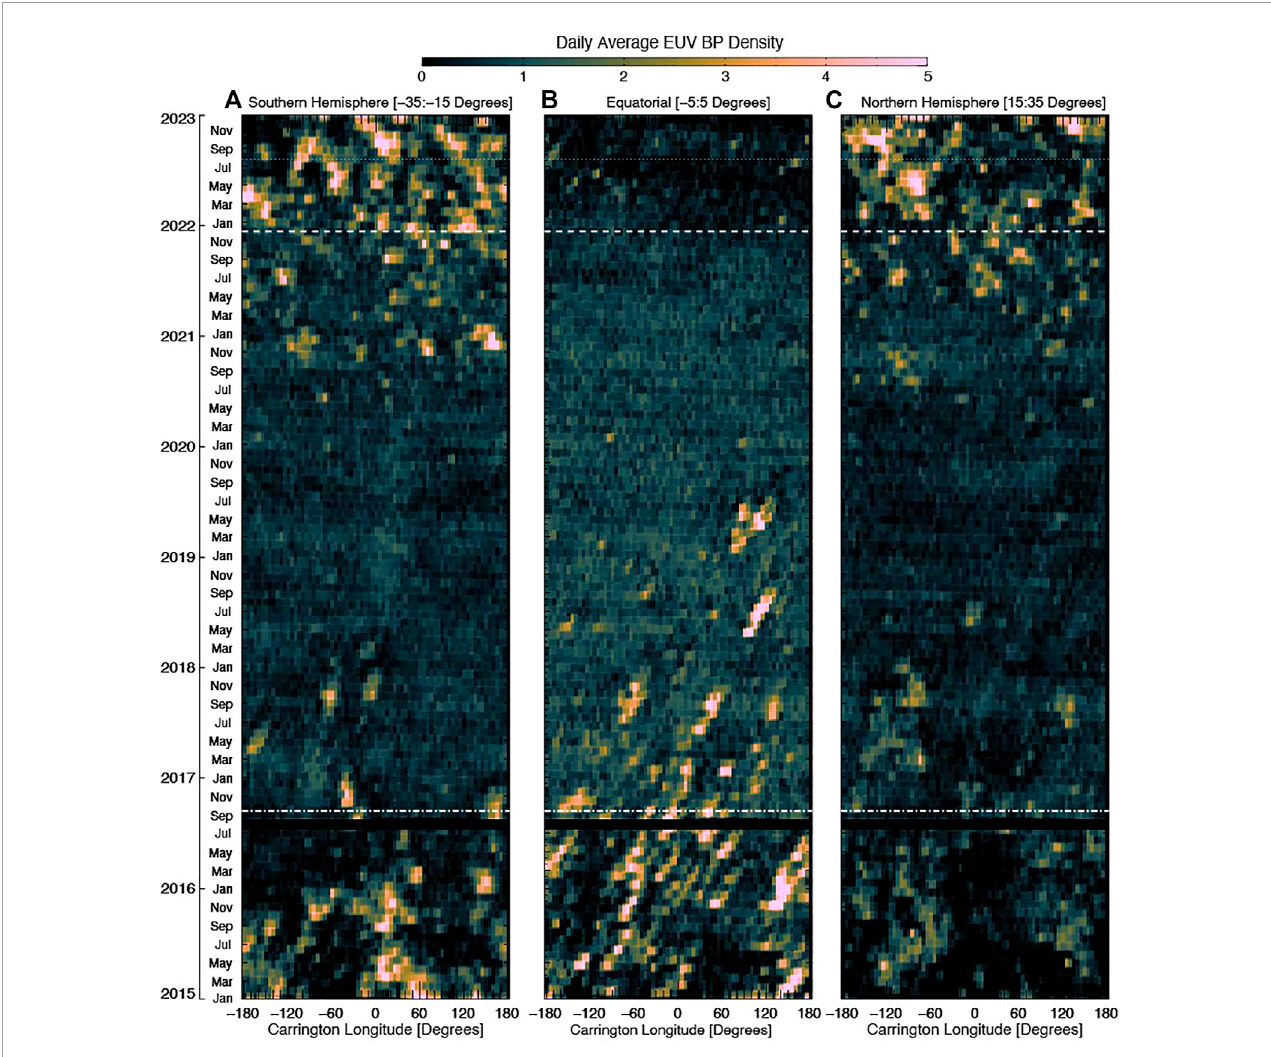
FIGURE 5 Hovmöller diagrams (longitude versus time averaged over a fixed latitude range) of the SDO (AIA 193Å) EUV BPs since 2015 for the southern hemisphere activity band (averaging −35°: 15°), the equator (averaging −5°:5°) and northern hemisphere activity band (averaging 15°:35°). Each panel shows three horizontal lines - two dashed lines in September 2016 (Leamon et al., 2022) and the December 2021